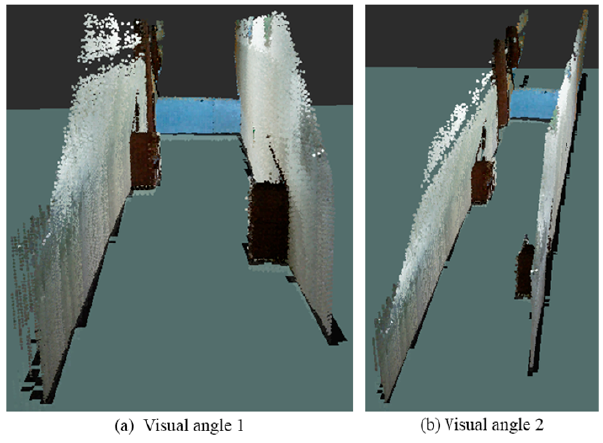
Figure 14. Dense 3D point cloud map of simulated